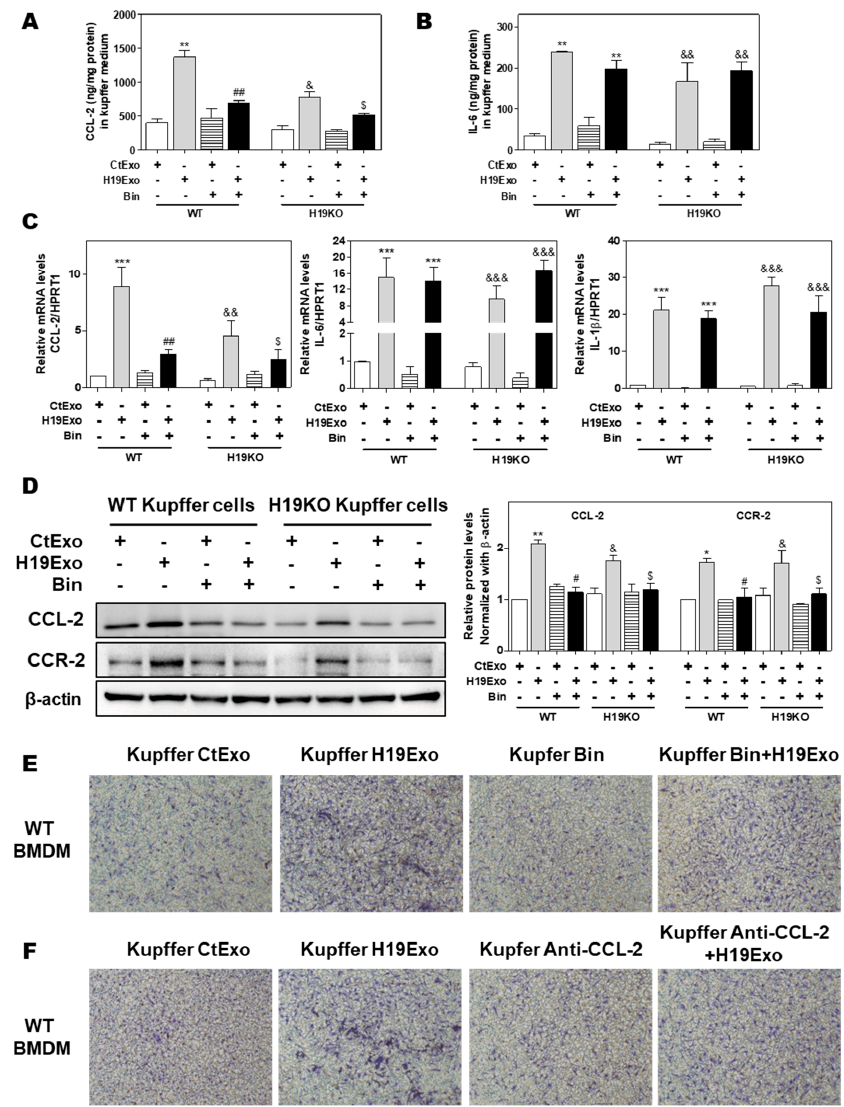
Figure 4. Effect of CCL-2 on exosomal H19-induced macrophage activation and migration. ( A–F ) Mouse Kupffer cells were treated with CtExo or H19Exo for 24 h, with or without pretreatment with Bindarit (Bin, 300 μ M) and purified CCL-2 antibody (Anti-CCL-2, 20 μ g/mL) for 2 h. ( A , B ) The levels of CCL-2 and IL-6 in the conditioned medium of Kupffer cells were measured by ELISA assay and normalized using protein concentration. ( C ) The relative mRNA levels of CCL-2, IL-6, and IL-1 β were measured by real-time RT-PCR and normalized using HPRT1. ( D ) Representative immune blot images of CCL-2 and CCR-2 are shown. Relative protein levels were normalized using β -actin. ( E , F ) Representative images of migration assay are shown. Results from at least three independent experiments are presented as Mean ± SEM. Statistical significance: * p < 0.05, ** p < 0.01, *** p < 0.001, compared with WT control group; # p < 0.05, ## p < 0.01, compared with WT H19Exo group; & p < 0.05, && p < 0.01, &&& p < 0.001, compared with H19KO control group; $ p < 0.05, compared with H19KO H19Exo group.